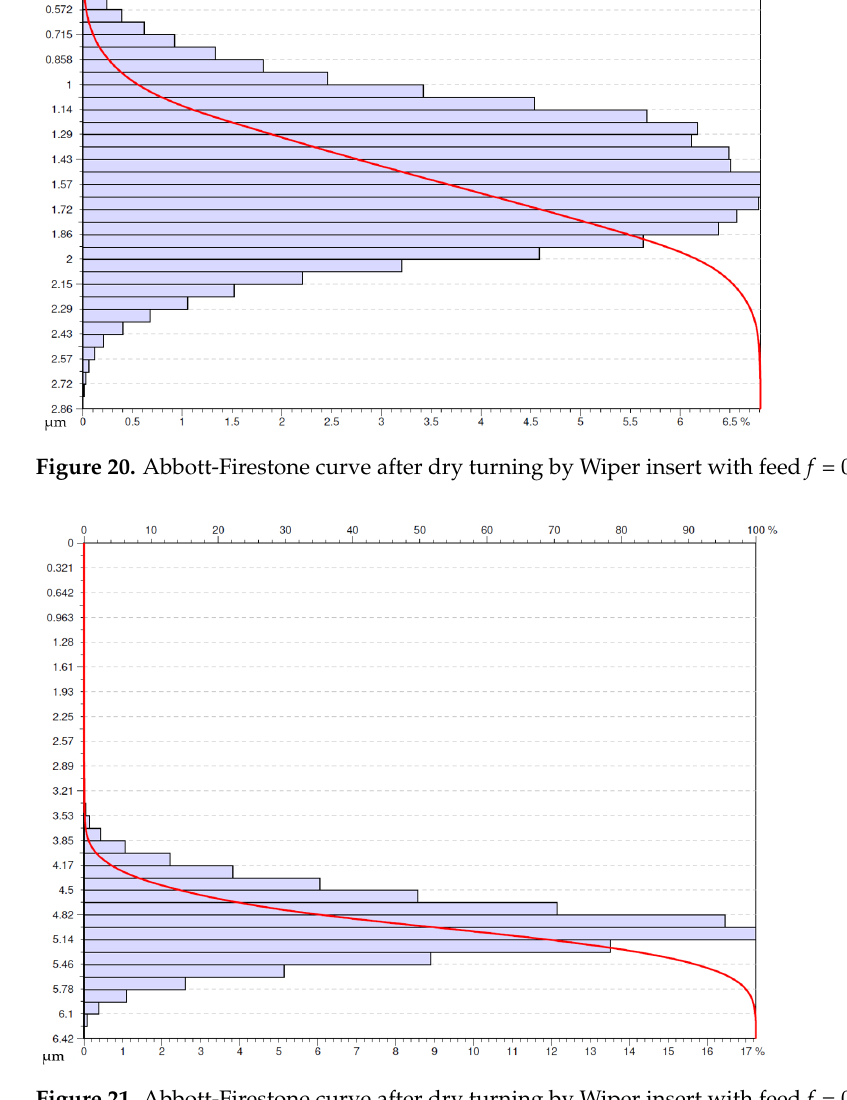
Figure 21. Abbott-Firestone curve after dry turning by Wiper insert with feed f = 0.15 mm/rev.